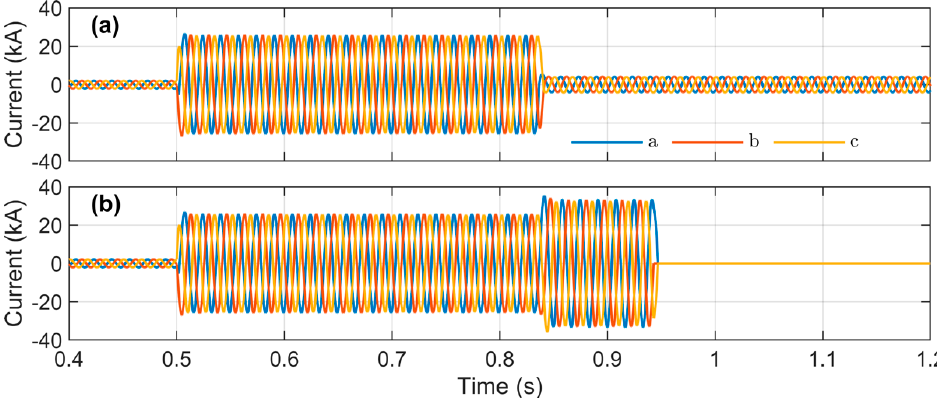
11 of 16 Figure 18. Operation of circuit breakers in case DCR fails. Three-phase currents of two HTS cables are shown in Figure 19 and power flow into two cables is shown in Figure 20. Three-phase-to-ground fault occurred at 0.5 s and lead to a rapid increase of current and power through two HTS cables. The opening of CB 3 at 0.84 s results in the reduction of current and power in HTS